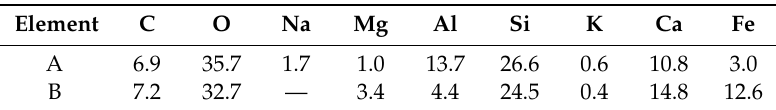
Table 7. Energy-dispersive spectrometer (EDS) quantitative results of anorthite crystals and gehlenite and pyroxene solid solution in 80%-O 2 slag (wt %).